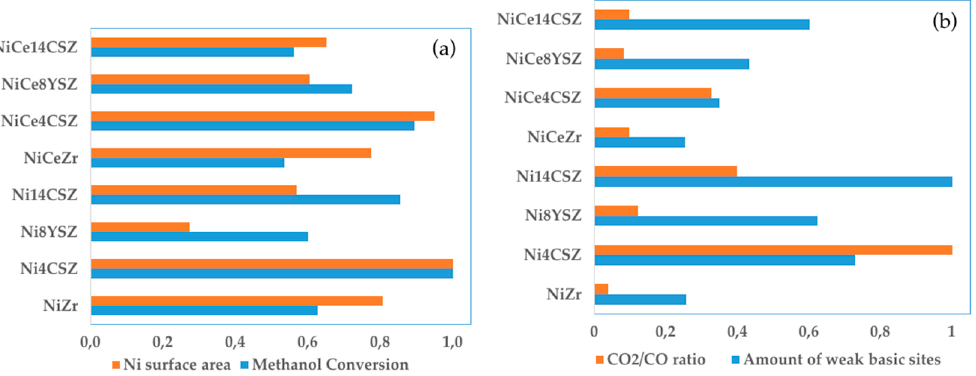
Figure 9. ( a ) Ni-surface area and methanol conversion (normalized values); ( b ): CO 2 / CO ratio and amount of weak basic sites (normalized values).